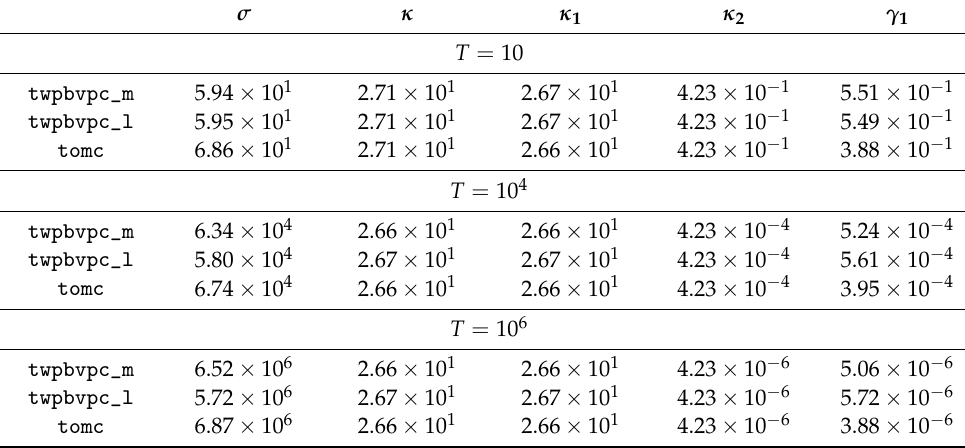
Table 10. Hypersensitive problem using the variable τ = t / T : conditioning parameters computed using tol = 10 − 6 and initial mesh with 11 equidistant